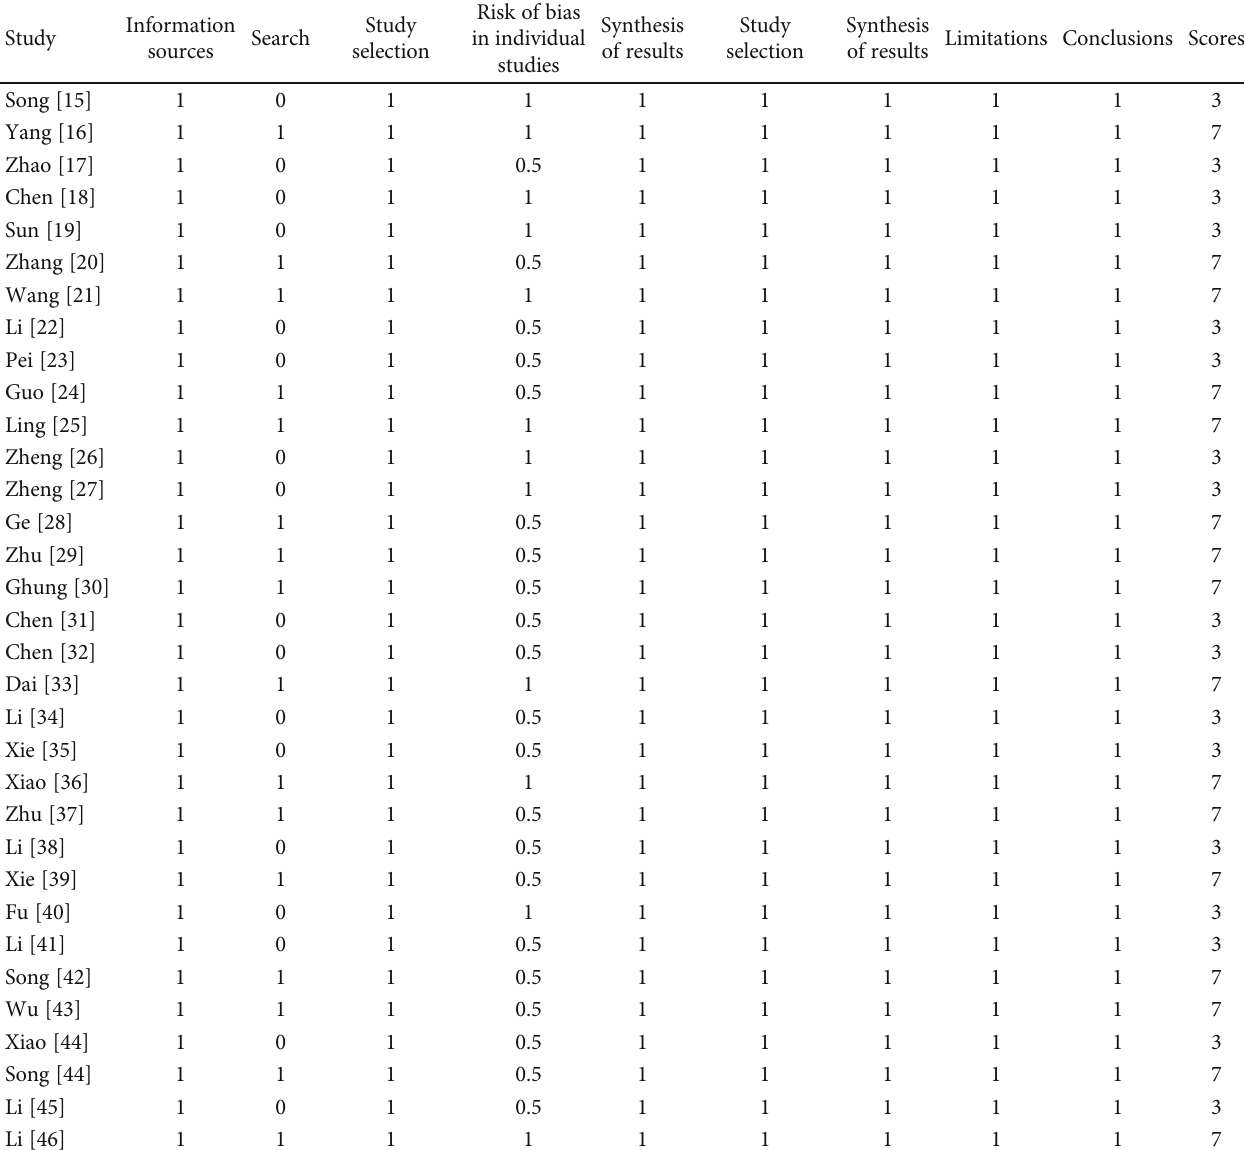
Table 2: The results of OQAQ